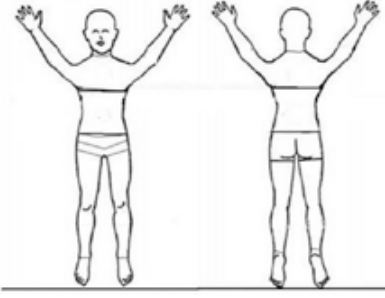
Figure 1. Supporting drawing used for quick